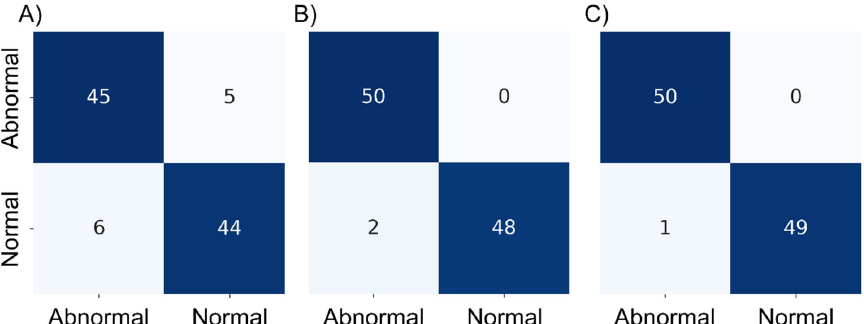
Figure 9. Confusion matrix in the ( A ) ML, ( B ) ensemble with CNNs, and ( C ) ensemble with CNNs and ML models. The horizontal and vertical labels indicate the prediction by each model and ground truth, respectively. ( A ) The ML model showed an accuracy of 89% (abnormal 45/50, normal 44/50). ( B ) The ensemble model with three CNN models showed accuracies of 98.0% (abnormal 50/50, normal 48/50) and 99% (abnormal 50/50, normal 49/50). ( C ) The ensemble with three CNNs and ML models showed an accuracy of 99% (abnormal 50/50, normal 49/50). Abbreviation: ML, machine learning.